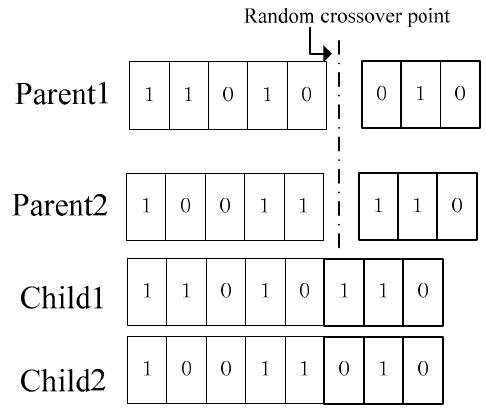
Figure 6. Schematic diagram of crossover.